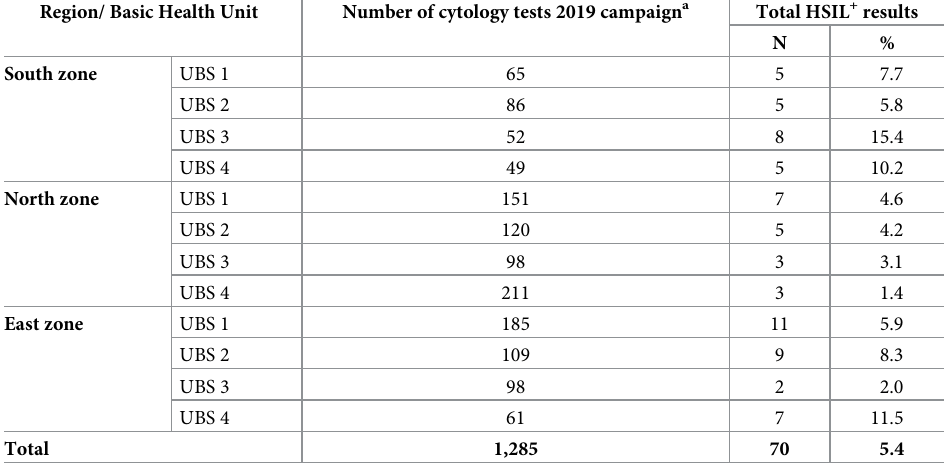
UBS: Unidade Ba´sica de Sau´de; HSIL + : High-grade intraepithelial lesion or worse (includes atypical squamous cells